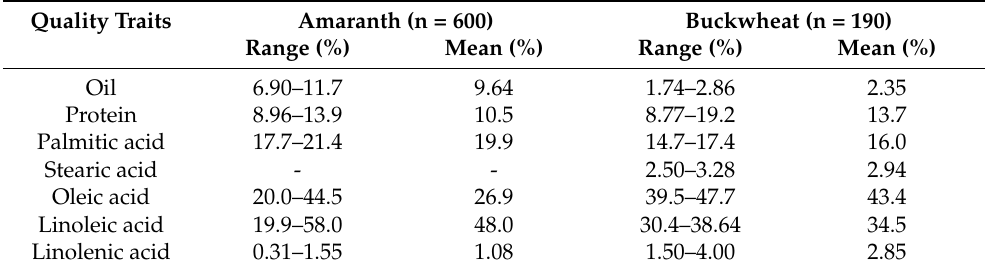
Table 4. Prediction values of amaranth and buckwheat for quality traits to check the applicability of the developed models.